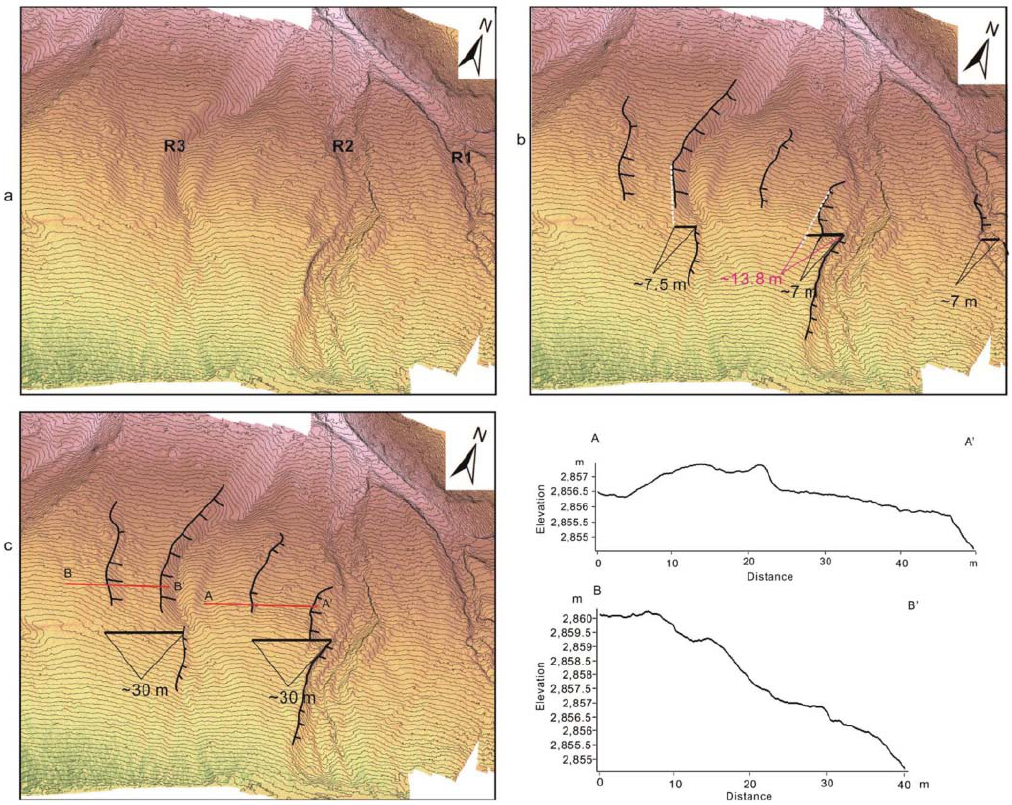
Figure 4. ( a ) Digital elevation model with contour lines (0.25 m interval) for R1, R2 and R3. ( b ) Interpretation of terrace risers and reconstruction of the ~7 m offset. ( c ) Reconstruction of the ~30 m offset [113].